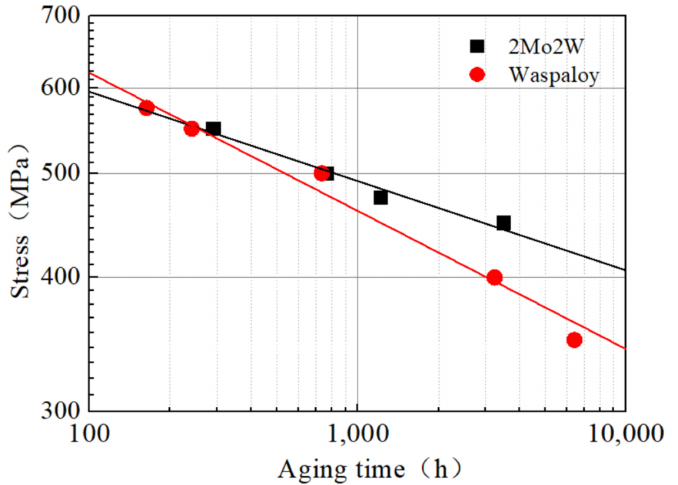
Figure 8. Stress–time creep logarithmic plots for 2Mo2W and